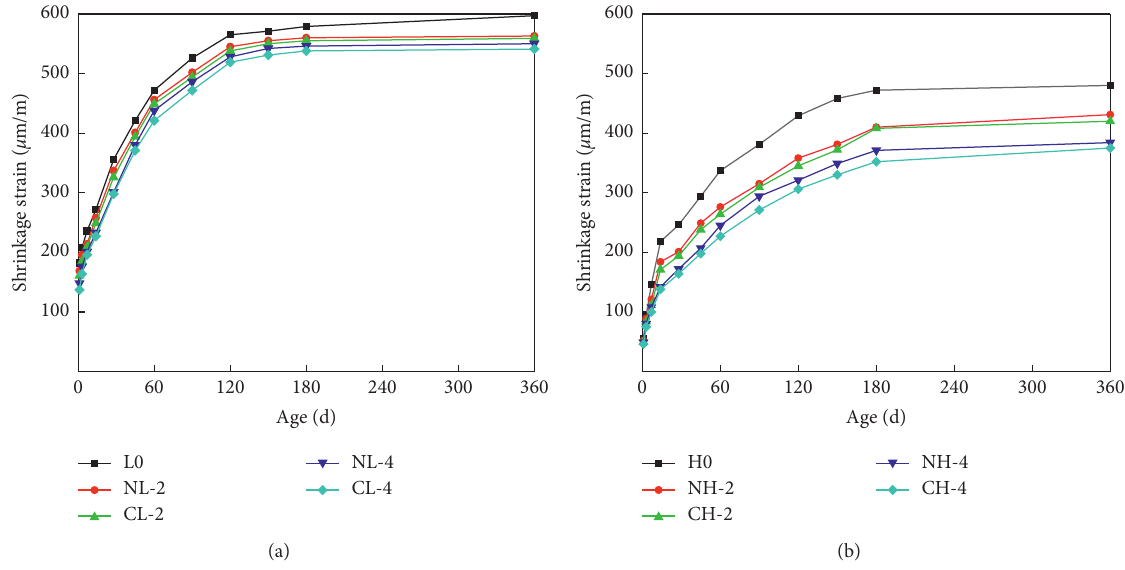
Figure 17: Shrinkage rate of concrete at different ages. (a) C30. (b)